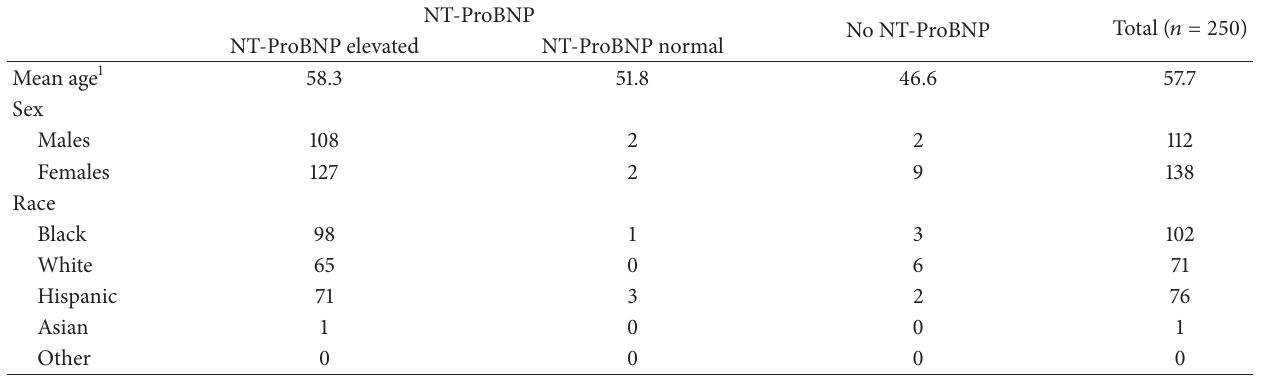
Table 1: Sample population